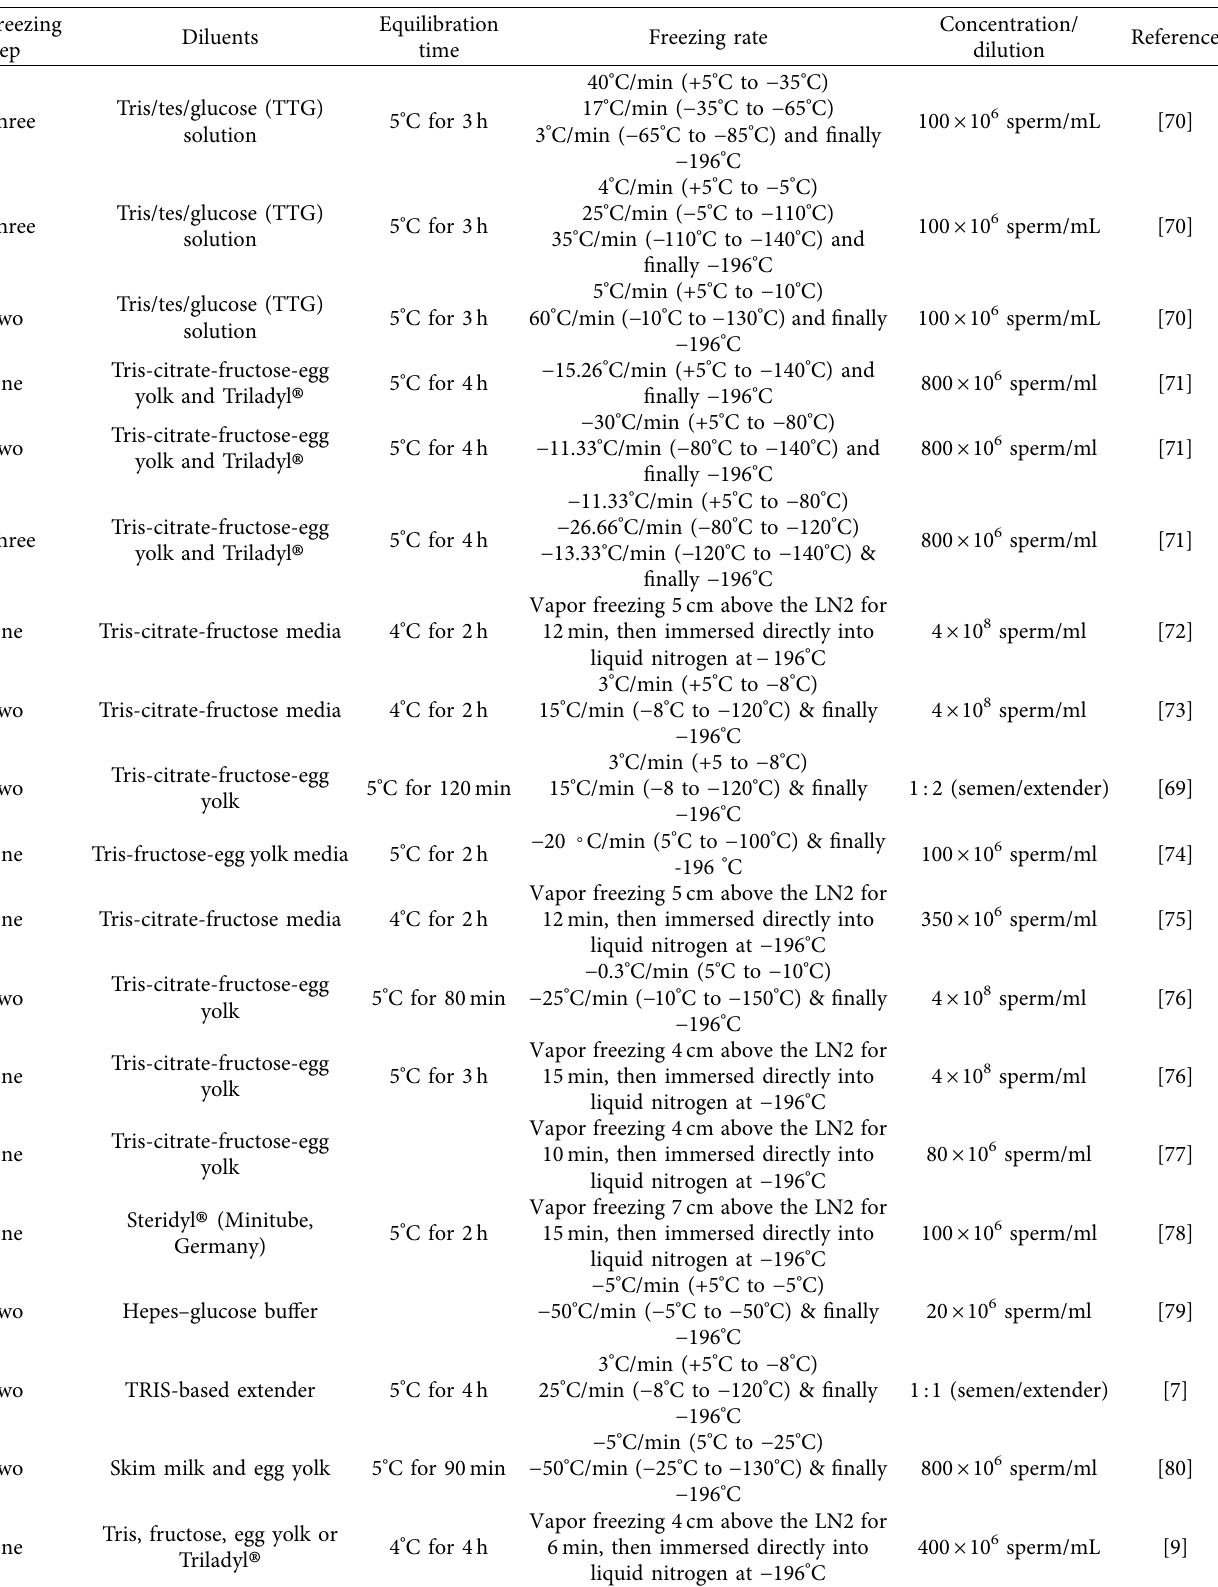
Table 2: Comparison of various protocols for freezing of ram